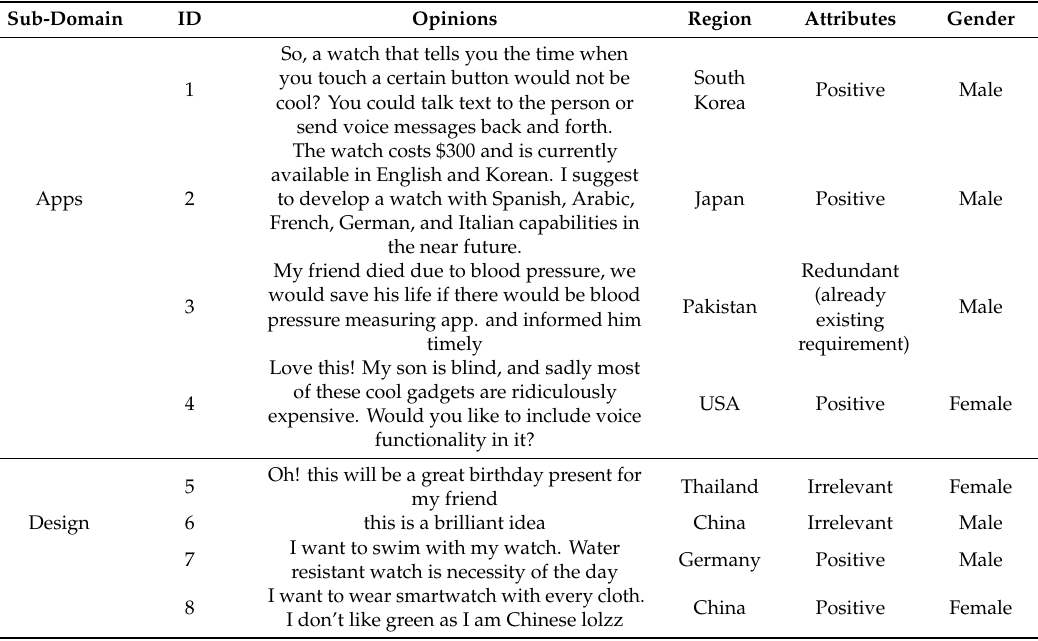
Table 3. Examples of initial opinion